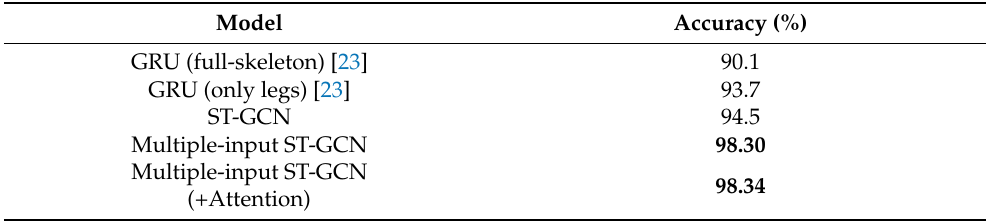
Table 4. Comparison of performance of proposed method with the schemes in the literature for pathological-gait dataset.